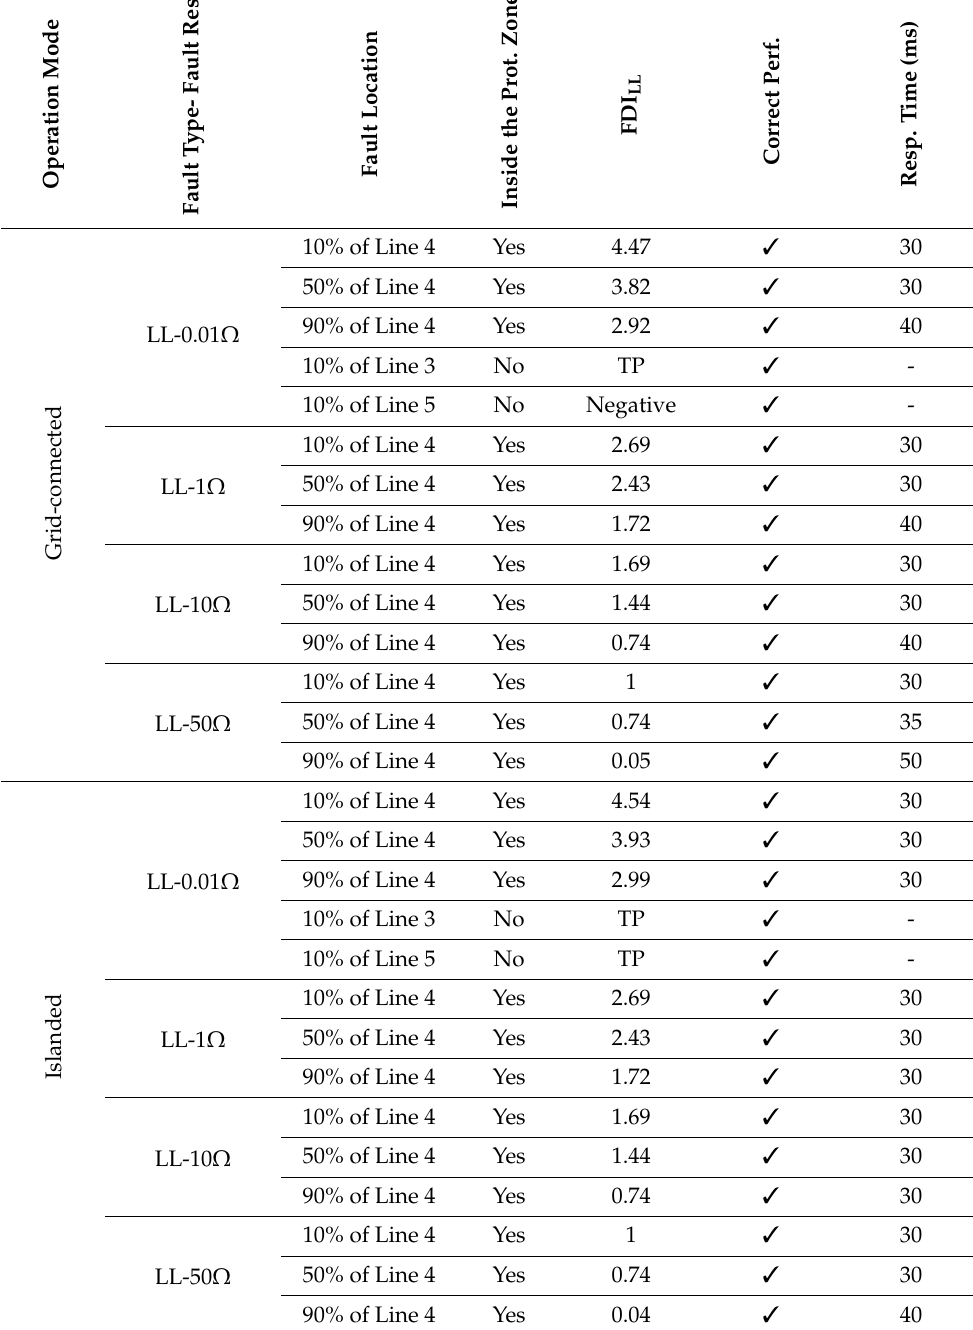
Table 3. Performance of the proposed main scheme in LL